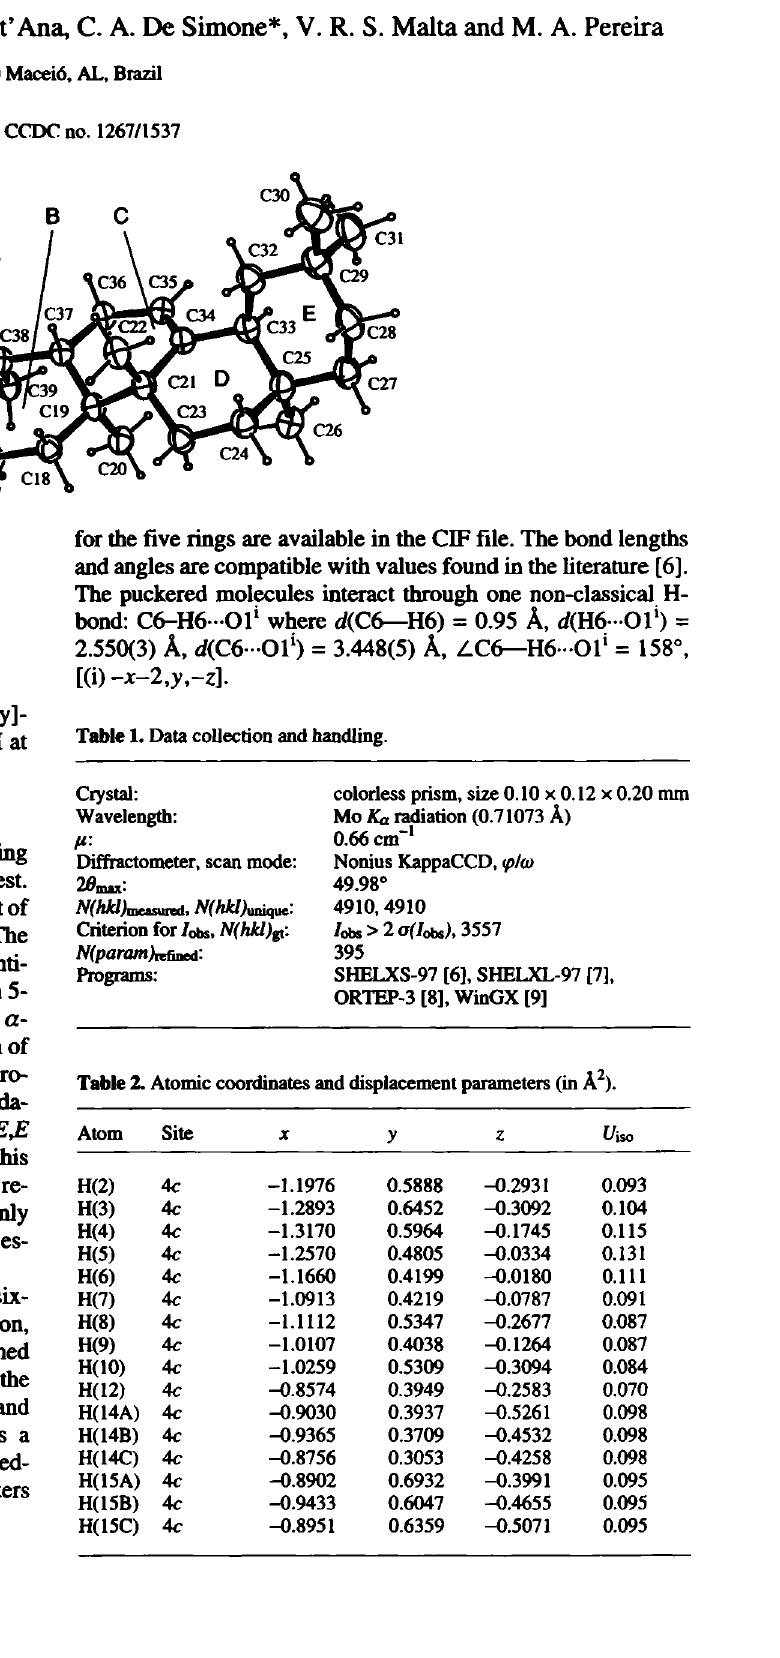
Table 2. Atomic coordinates and displacement parameters (in A 2